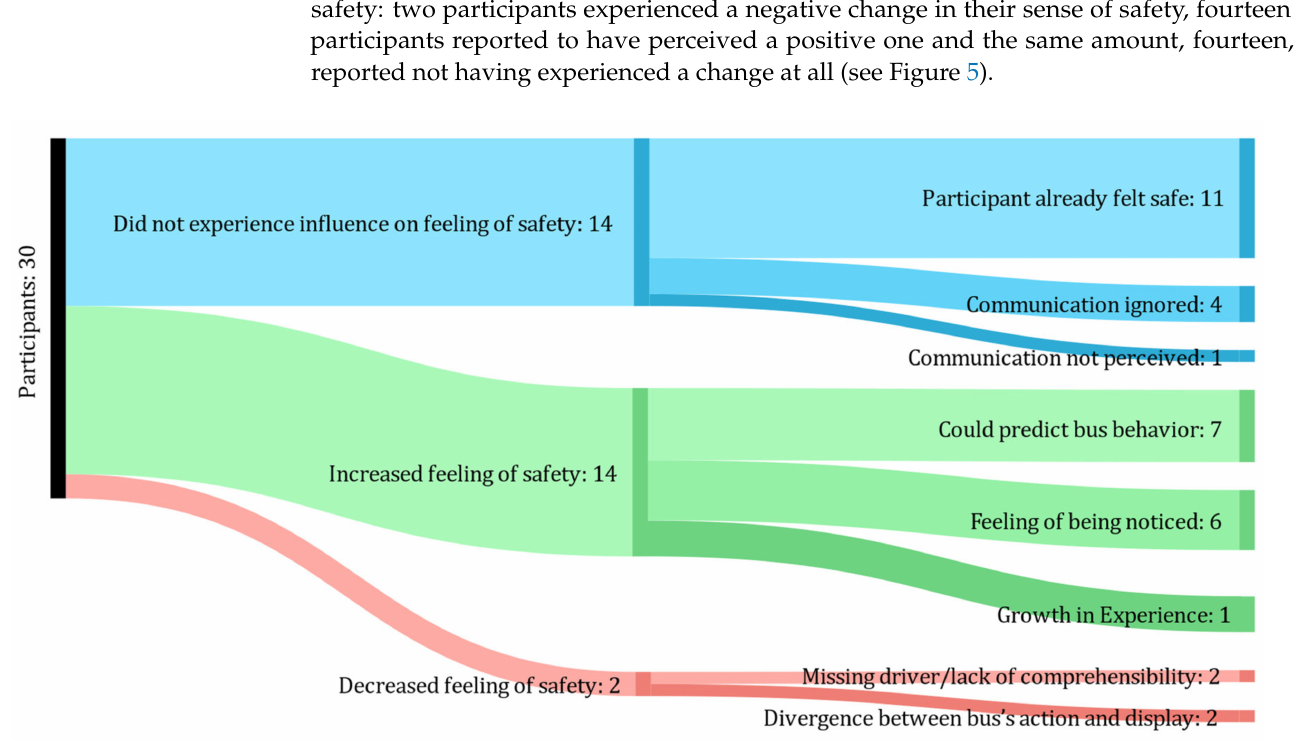
Figure 5. Frequencies of participants’ answers to interview question 2: did the external communication influence your sense of safety? Why